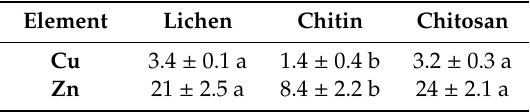
Table 1. Metal concentrations (mean ± SE, µ g / g · dw) in control samples. Di ff erent letters (a, b) indicate statistically significant ( p < 0.05) di ff erences among